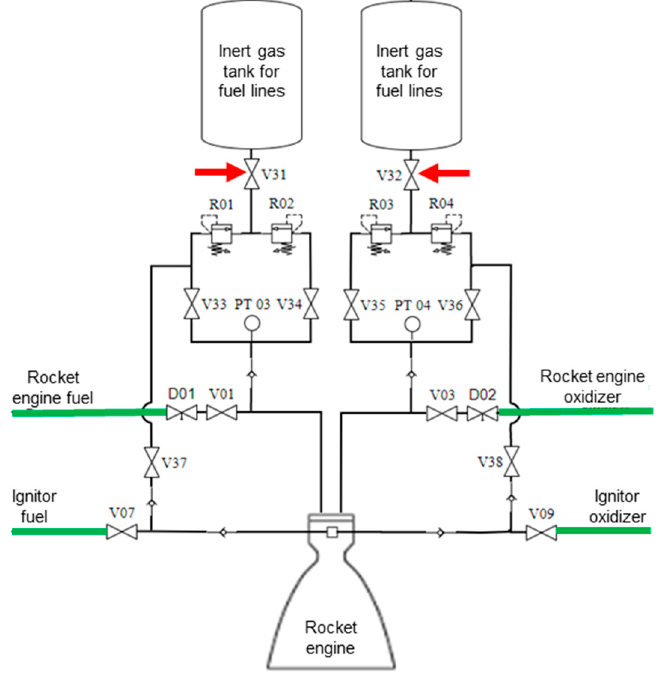
Figure 37. Algorithm’s 15th step diagram.